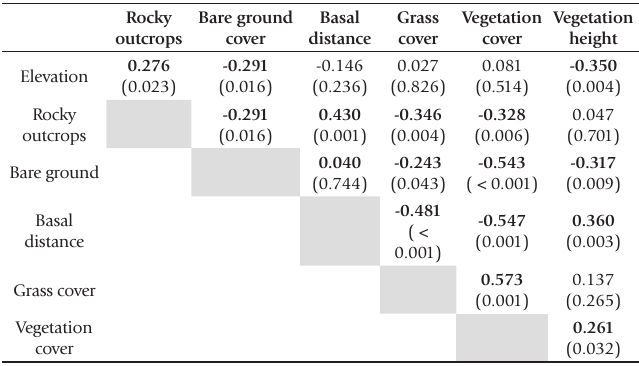
Table 3. Spearman’s correlation coefficient (rho) test for relationships among environmental variables. The variables were elevation, rocky outcrop cover, bare ground cover, grass cover, total vegetation cover, vegetation height and basal distance. Rho-values are listed (range: -1 to 1), with P-values in parentheses. Significant correlations in bold. Rocky Bare ground Basal Grass Vegetation outcrops cover distance cover cover